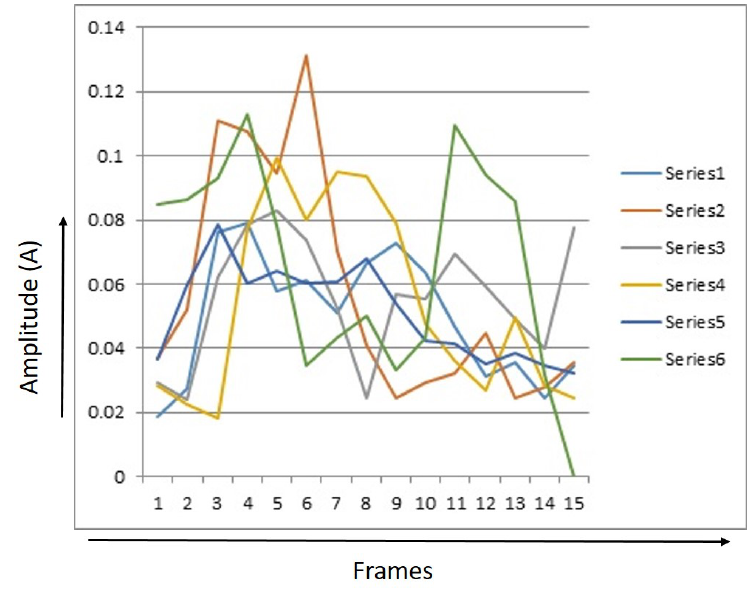
Figure 9. 15 Point RMS values of 6 event signals of